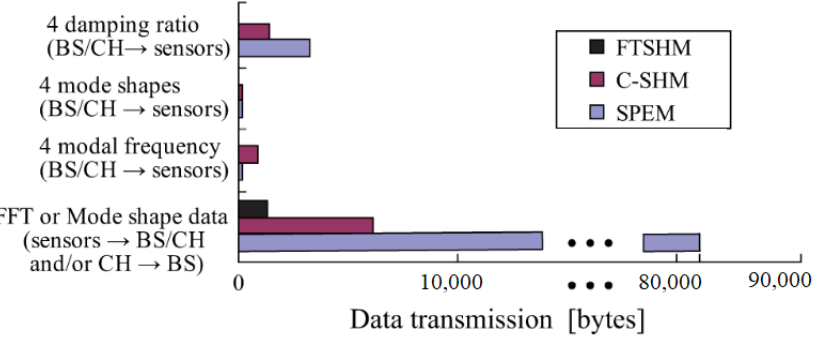
Figure 13. Data transmission in different WSN-based SHM approaches with 10-sensors deployed on a real structure [162].